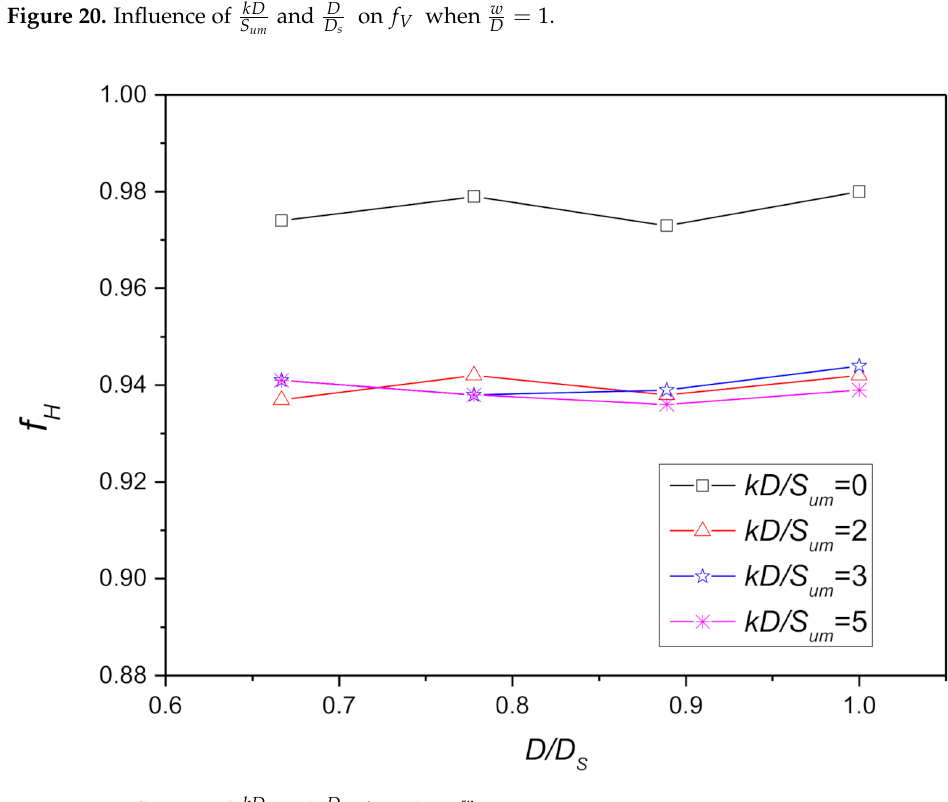
f H when w and D D s S um